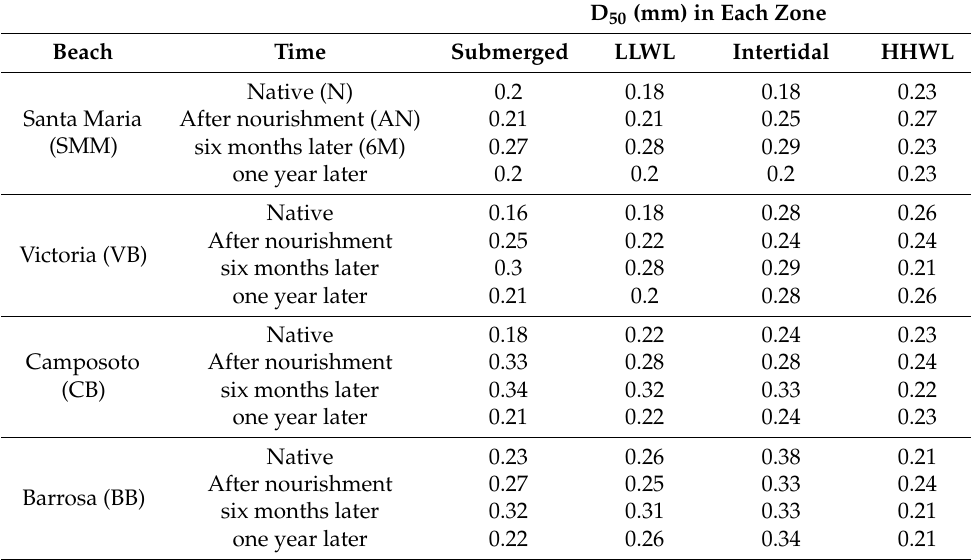
Table 2. Values of D 50 at SMM, VB, CB, and BB for each monitoring campaign. D 50 (mm) in Each Zone Beach Time Submerged LLWL Intertidal